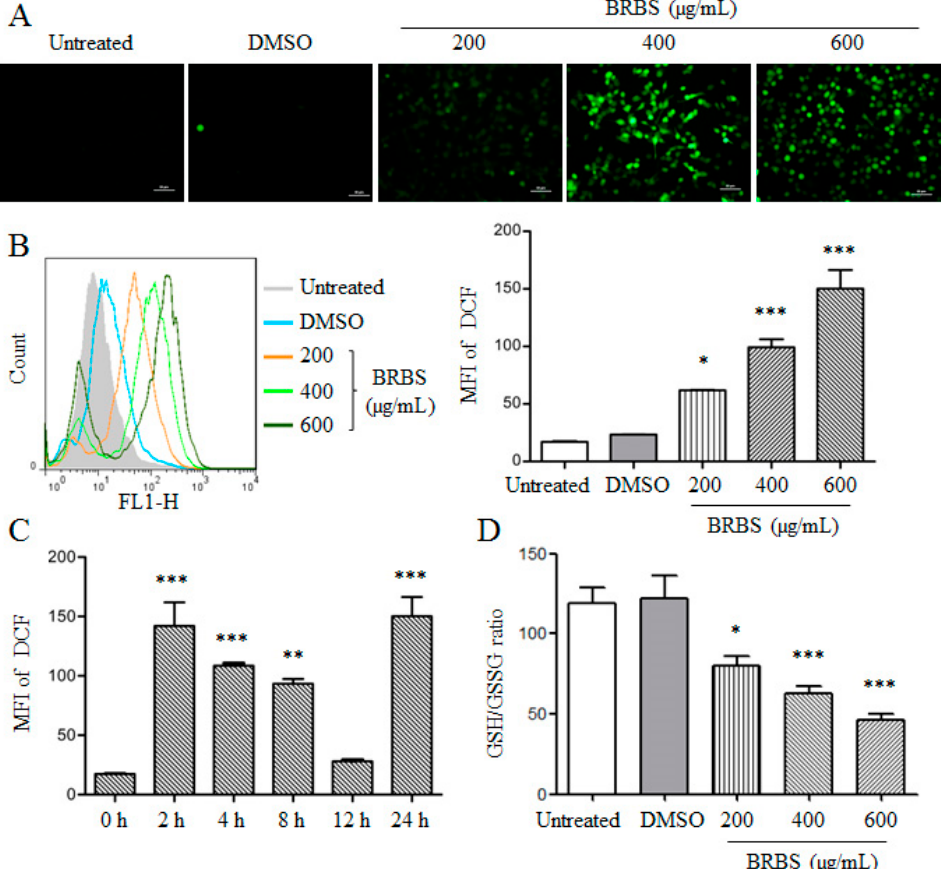
Figure 5. BRBS induces ROS generation in A549 cells. Cells were treated with different concentrations of BRBS for 24 h and stained with 2 ′ ,7 ′ -Dichlorodihydrofluorescein diacetate (DCFH-DA). Samples were analyzed by inverted fluorescence microscopy (Scale bar = 50 µm) ( A ) and flow cytometry ( B ); ( C ) cells were treated with 600 µg/mL BRBS for 2, 4, 8, 12 and 24 h respectively, and stained with DCFH-DA. Samples were analyzed by flow cytometry; ( D ) cells were treated with BRBS for 24 h and the intracellular glutathione reduced/oxidized (GSH/GSSG) ratio was measured. * p < 0.05; ** p < 0.01; *** p < 0.001 compared to Untreated.